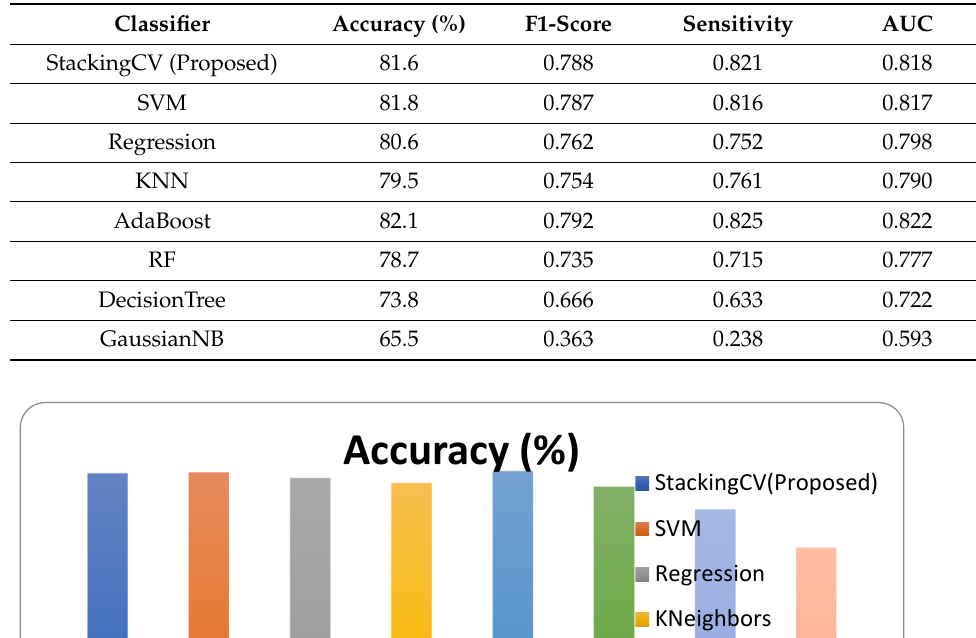
Table 2. Performance of the system for Resnet50 feature extraction.